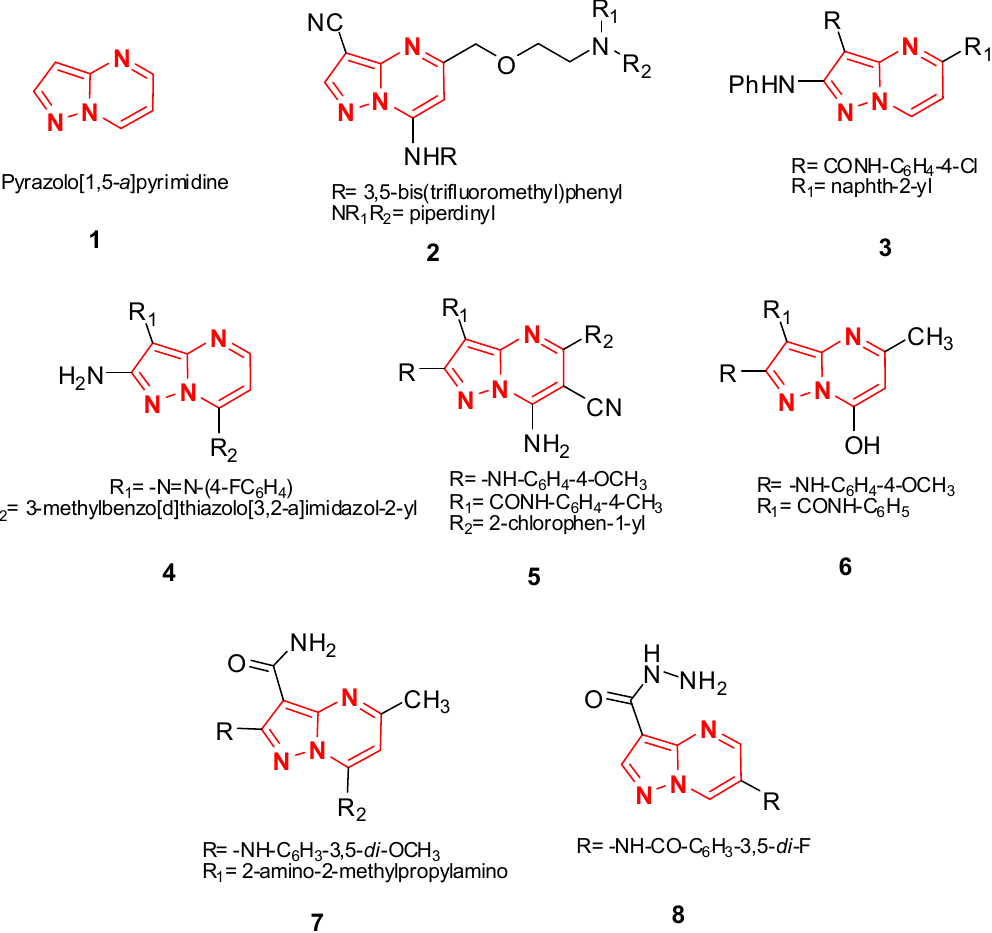
Figure 1. Structures of the antitumor activity compounds 1 – 6 and enzymes inhibitors 7 – 8.